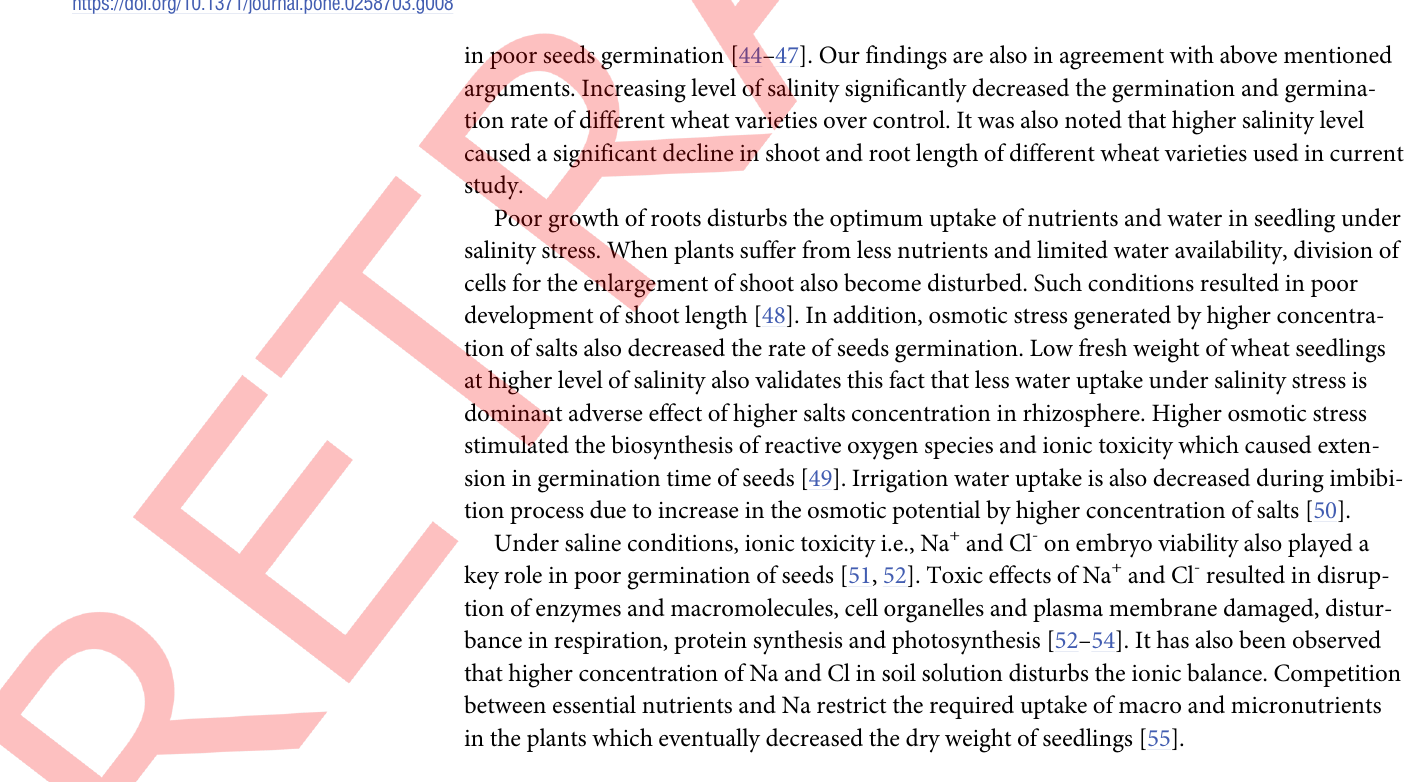
Fig 8. Principal component analysis for the effect of varieties on germination and seeding growth of four wheat varieties.